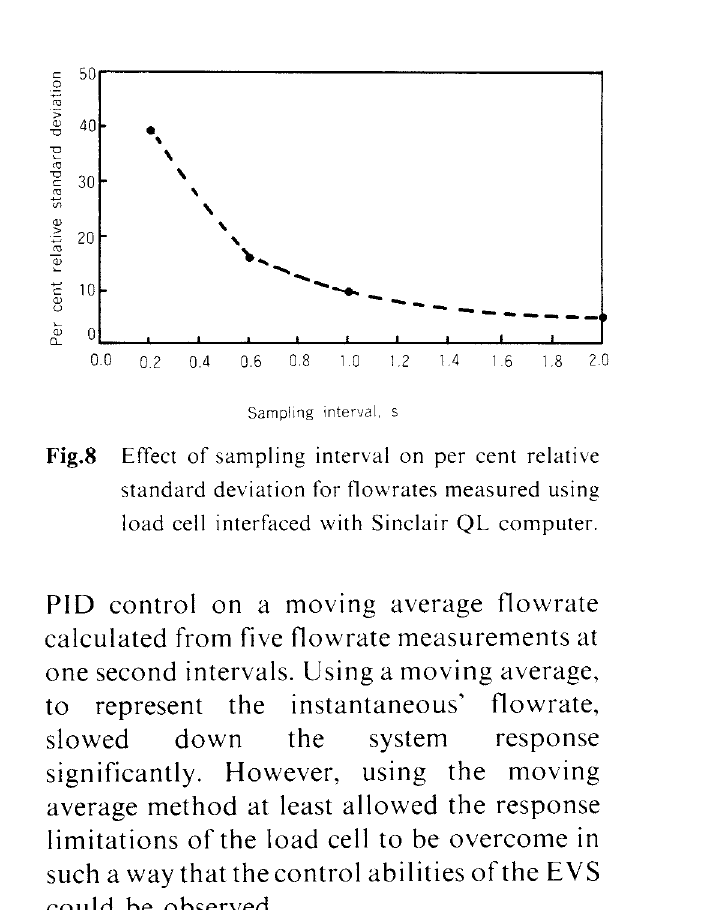
Fig.8 Effect of sampling interval on per cent relative standard deviation for tlowrates measured using load cell interfaced with Sinclair QL computer.